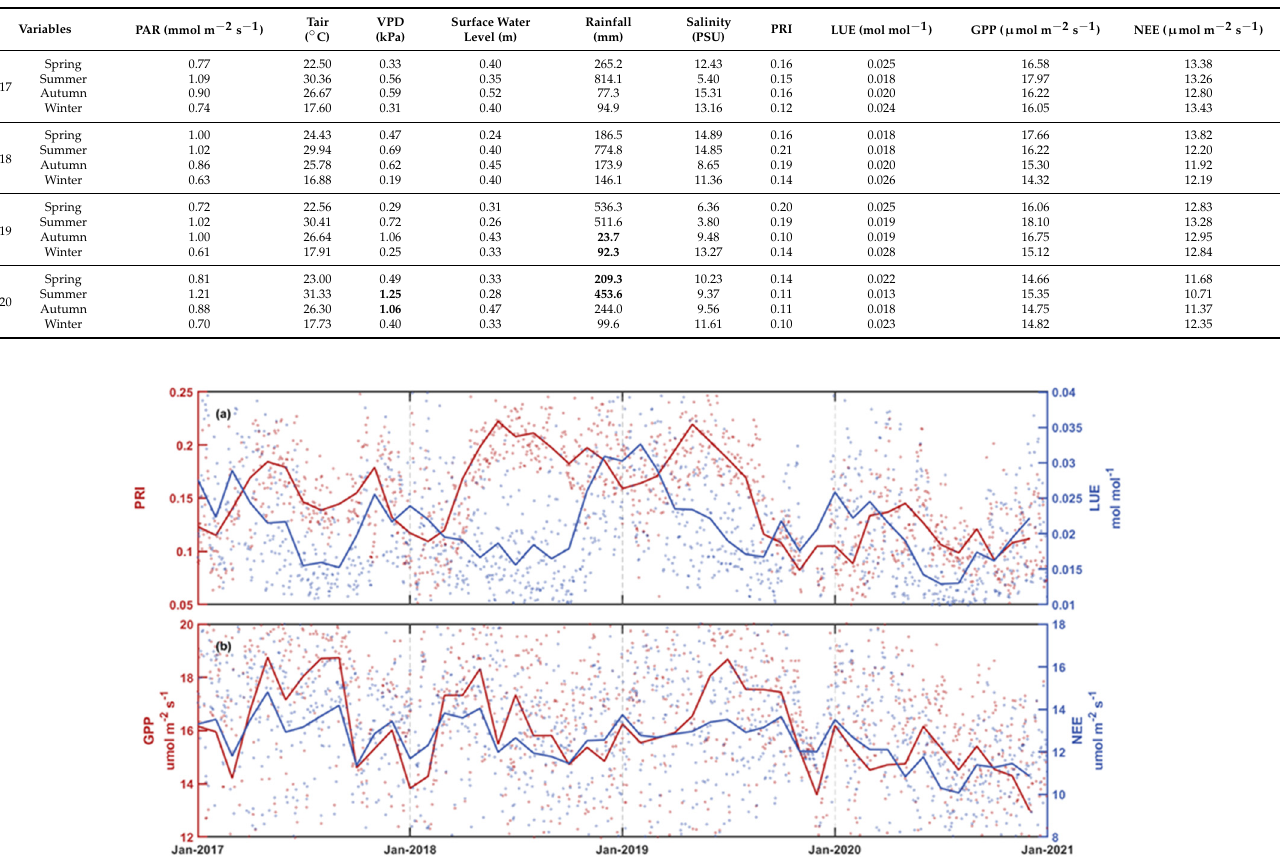
Table 1. Seasonal mean values of environmental, spectral, and carbon-related variables from January 2017 to December 2020, with higher VPD and lower rainfall values indicating the 2019–2020 drought stress highlighted in bold.